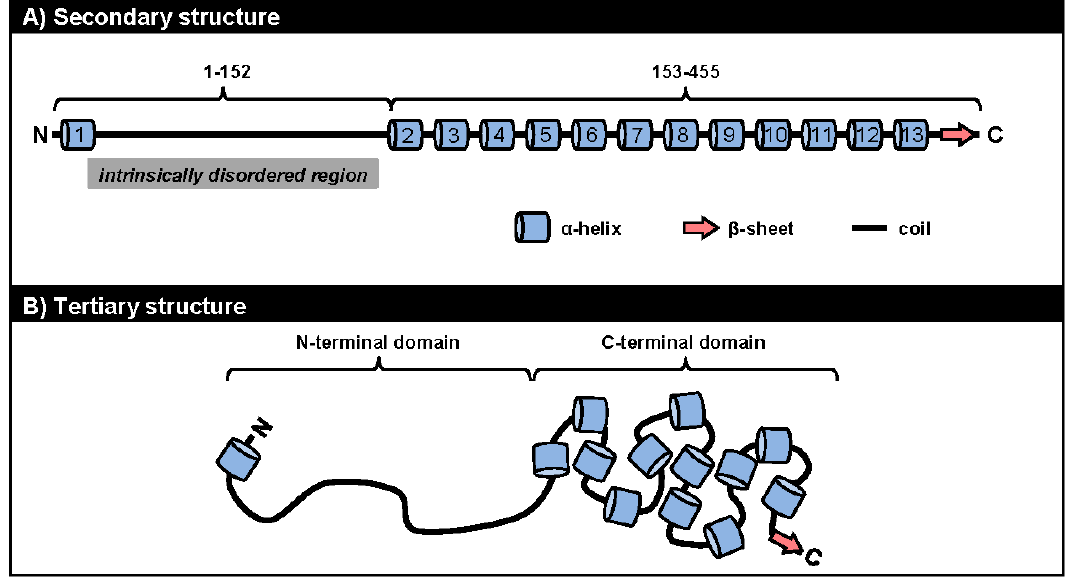
Figure 3. The structural conformation of ORF57 protein. The ORF57 secondary structure ( A ) predicted by the PSIPRED (Psi-blast based secondary structure prediction) version 3.0 prediction tool (http://bioinf.cs.ucl.ac.uk/psipred/) [95] is composed of 13 α-helixes (barrels), one β-sheet (thick arrow), and unstructured coils (thick lines) forming two structurally distinct domains: a unstructured N -terminal domain (aa 1–152) with an intrinsically disordered region (IDR) and an α-helix-rich C -terminal domain (aa 153–455); The proposed ORF57 tertiary structure ( B ) consists of a flexible linear N -terminal domain and a rigid globular C -terminal domain